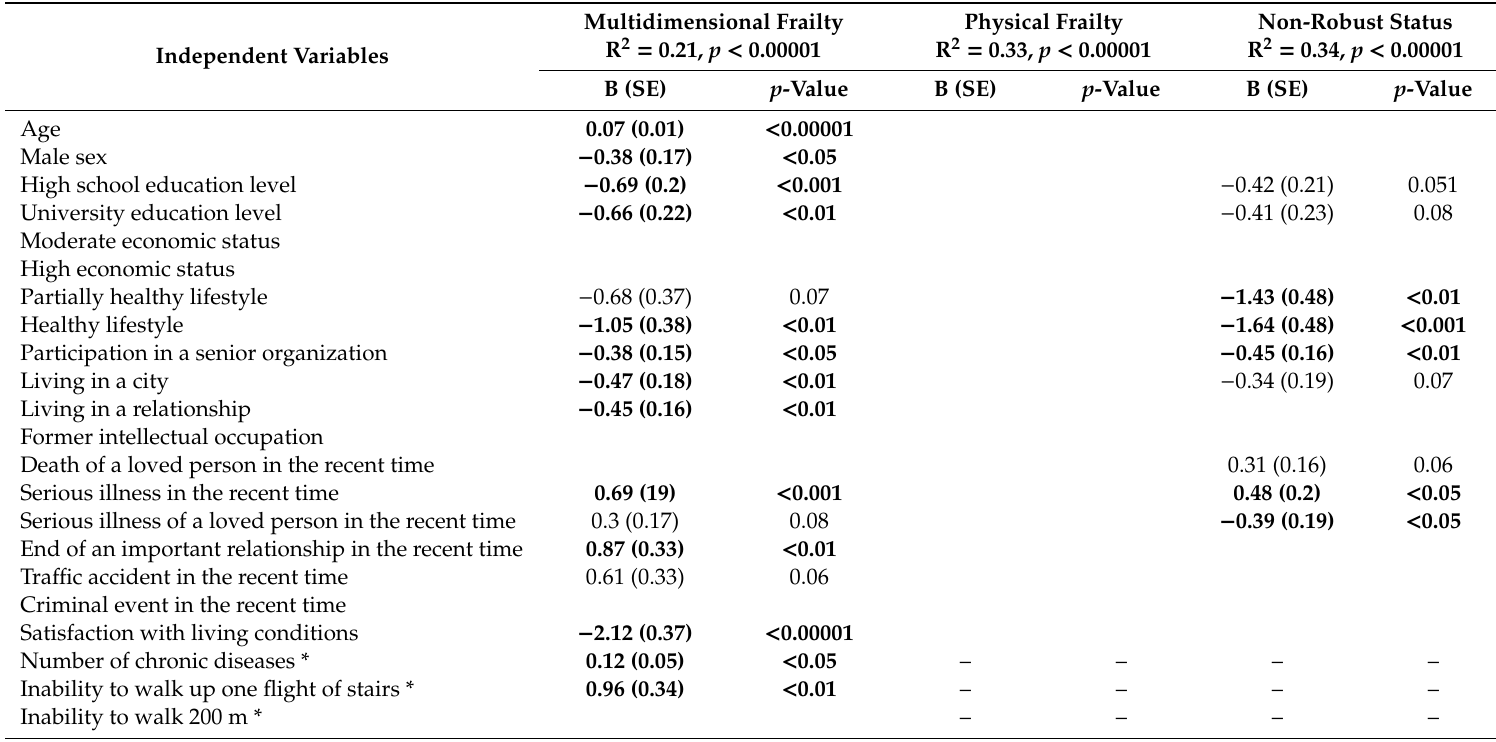
Table 2. Independent risk factors of multidimensional and physical frailty as well as non-robust